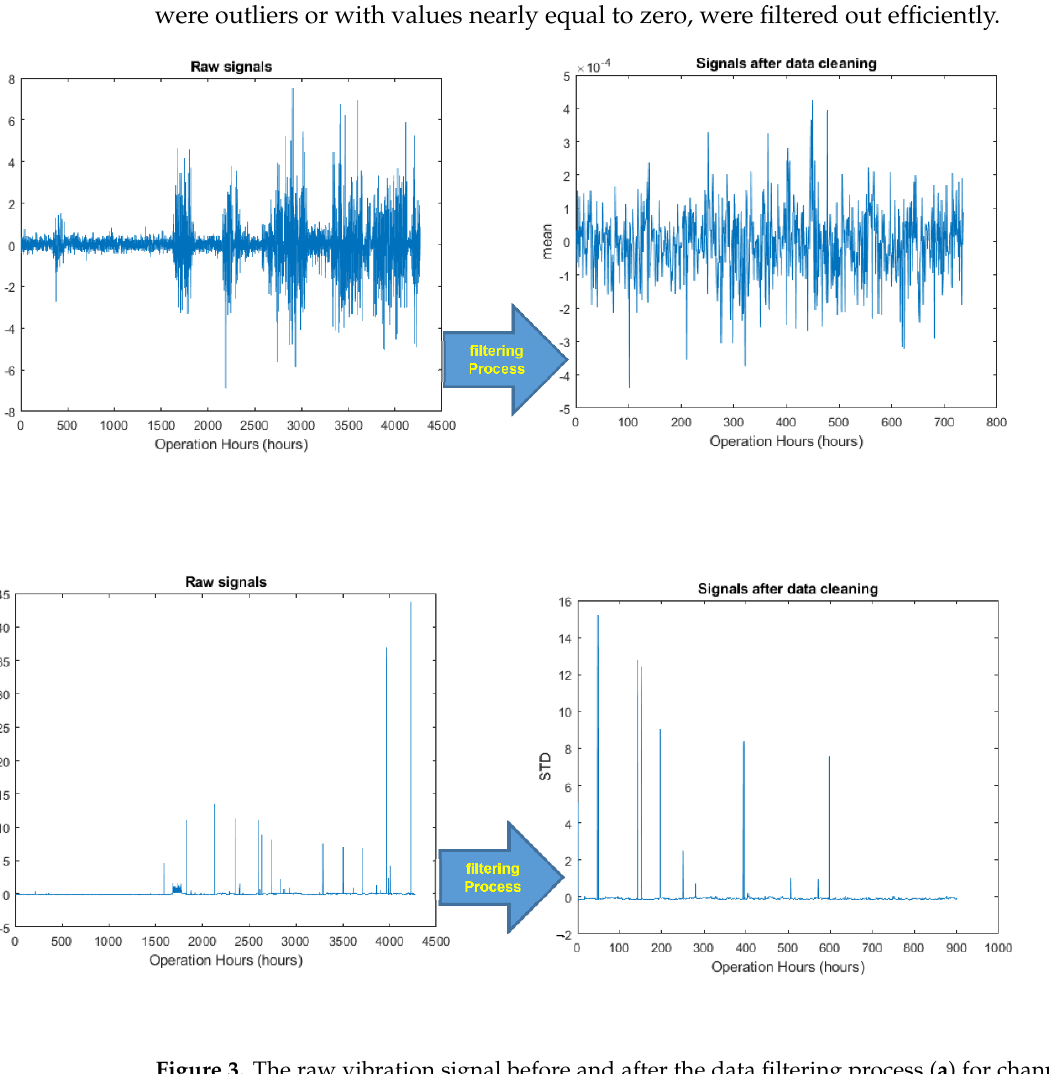
Figure 3. The raw vibration signal before and after the data filtering process ( a ) for channel 2 and ( b ) channel